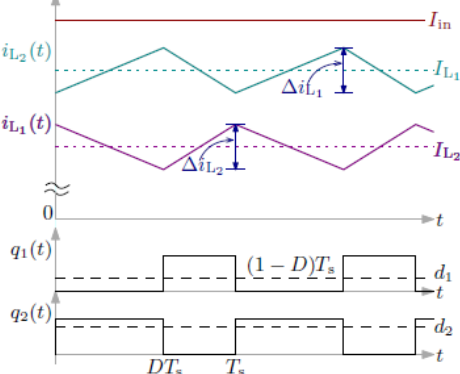
Figure 5. Graphical representation of the switching functions q j (t) : complementary PWM technique.